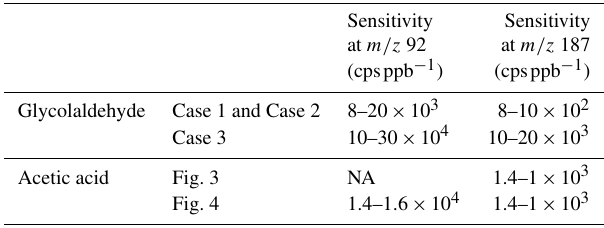
Table 5. Glycolaldehyde and acetic acid PCIMS reaction cell sen- sitivities (cpsppb − 1 ) for the 1700–7500ppm reaction cell water vapor mixing ratio range. Glycolaldehyde sensitivities at m/z 92 ( GA ) ) and m/z 187 (I − ( GA ) ) are for the Henry’s Law source (O − 2 experiment, T = 288K. Acetic acid microfluidic sensitivity at m/z 92 (O − ( HAc ) ) and m/z 187 (I − ( HAc ) ) are based on labo- 2 ratory and field data presented in Figs. 3 and 4. All sensitivities are reported from low to high water.